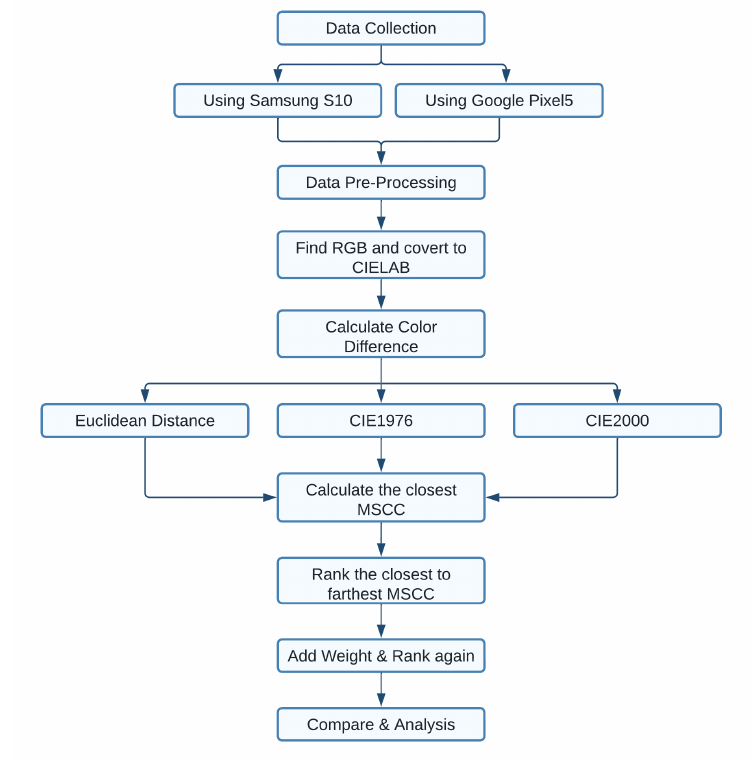
Figure 5. Flow diagram of the